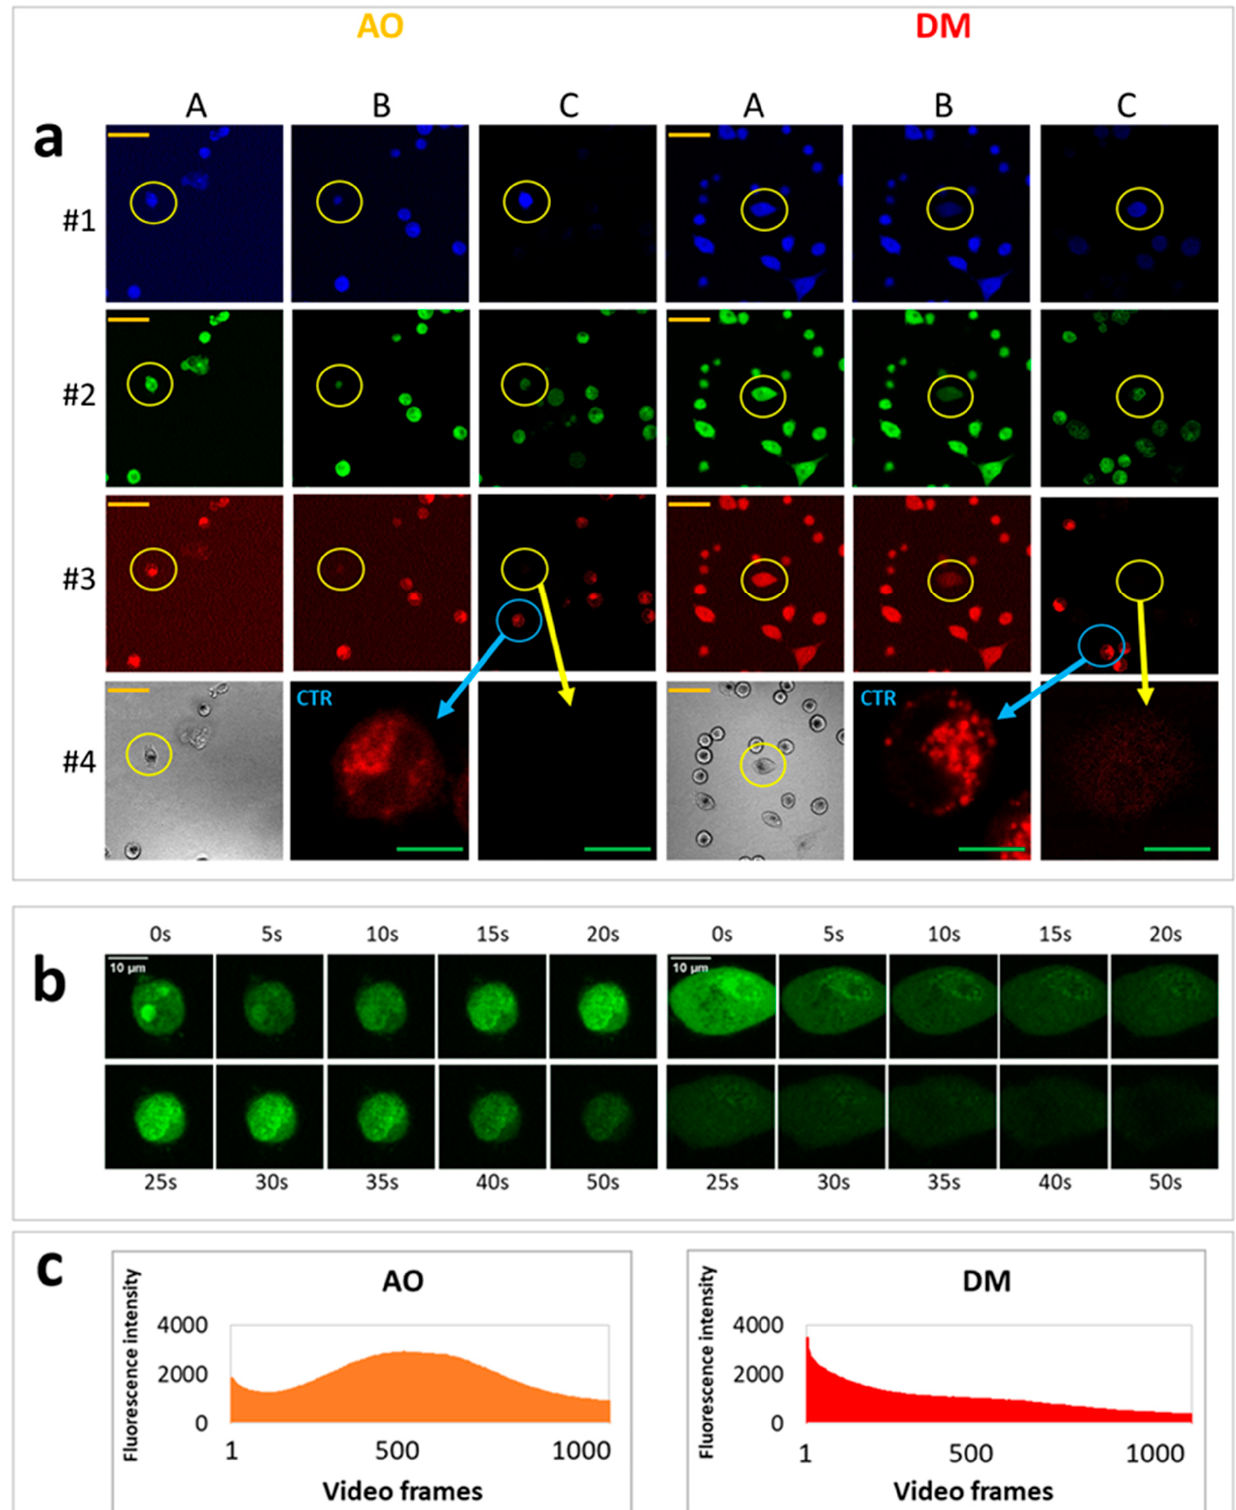
Figure 7. Lysosomal localization of AO and DM in fluorescently-labeled HeLa cells. Both AO and DM dyes cause lysosomal permeabilization for light illumination. To monitor the changes in the integrity of lysosomes, LysoOrange dye was applied. The left side panels show the results of AO treatment, while the right-side panels are the DM results. Cells were pretreated with 2.5 µM concentration of AO or DM for 1 h. Then, the images of the cells were recorded continuously (at 1000 subsequent time points) by sequential laser illumination at 405, 488, and 543 nm. Cells were then stained with LysoOrange for 15 min and re-imaged ( a ), row #4, images B and C). During the experiment, cells were kept at 37 °C. Cell images were taken through various emission filters: 460/20 nm (( a ), row #1, targeting DM), 530/20 nm (( a ) row #2, targeting AO), 580/20 nm (( a ), row #3, targeting LysoOrange). Images in column “A” (rows #1–3) were recorded before the continuous illumination, while in column “B” (rows #1–3), images were taken after the continuous illumination. Images of column “C” (rows #1–3) were taken after the LysoOrange labeling of cells. The “A” image in row #4 of ( a ) are bright-field images of cells that are exposed to the mentioned continuous illumination. These cells are marked with yellow circles. The blue circles show control cells that were not illuminated. In the gallery of ( b ), we see cells at 530/20 nm emission as a function of time when illuminated with the 488-nm laser light. The time is given in seconds in the images. AO images, as a function of time, show a more robust signal initially localized to lysosomes. The sign shows an increase in the transient intensity of nuclei and later fades evenly. In the case of DM, a slower fading of the lysosomes can be observed. ( c ) Shows the integrated intensity of several cells as a function of time. There is an apparent transient increase in the intensity of cells, which is more pronounced for the AO treatment. At the same time, it is hardly seen with DM, but it still exists. At the level of individual cells, this transient increase in the intensity appears in cytoplasmic flashes at the 530/20 nm emission for both dyes. The yellow bar corresponds to 50 µm and the green bars to 10 µm. These experiments were repeated two more times, produc- ing similar results.